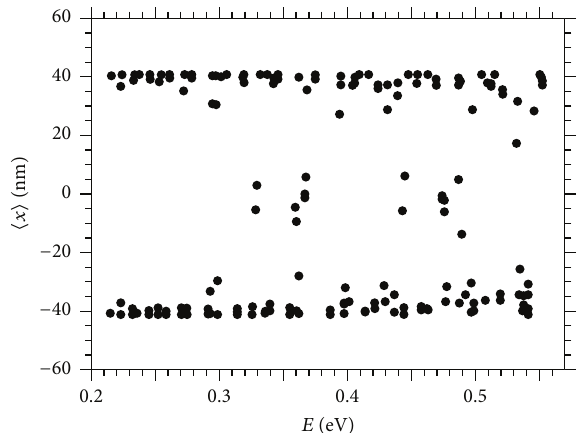
Figure 11: Average coordinate ⟨𝑥⟩ along single electron spectrum for the asymmetric circular/elliptic DQW for asymmetry parameter /𝑅 𝜉 = 39.8/40 = 0.995 . 𝜉 = 𝑅 2𝑦 2𝑥 ,